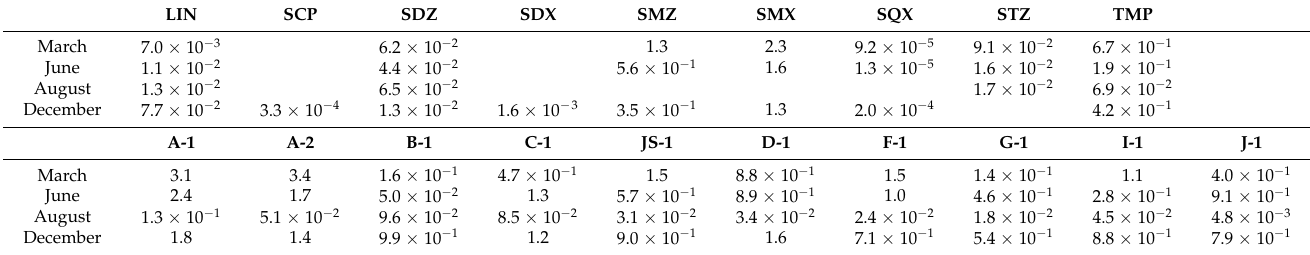
Table A5. Ecological risk assessment for antibiotics in the surface water samples during each sampling campaign. Blank cells indicate samples where no antibiotic could be